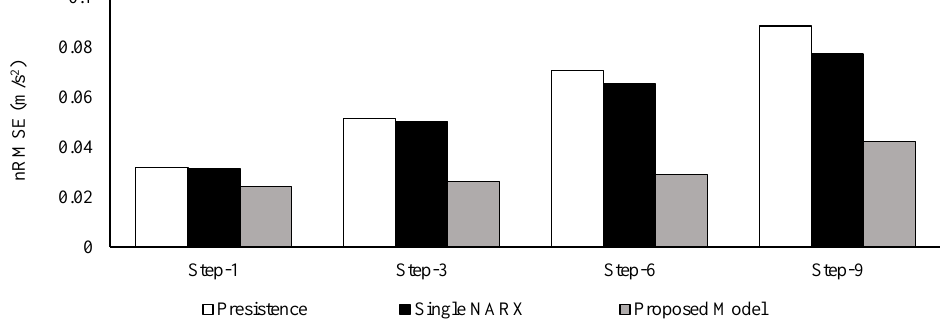
Figure 11. Normalized root mean square error (nRMSE) for the proposed ensemble NARX model vs. Figure 11. N ormalized root mean square error ( nRMSE) for the proposed ensemble NARX model vs. the single-network NARX and persistence model at di ff erent time the single-network NARX and persistence model at different time horizons.